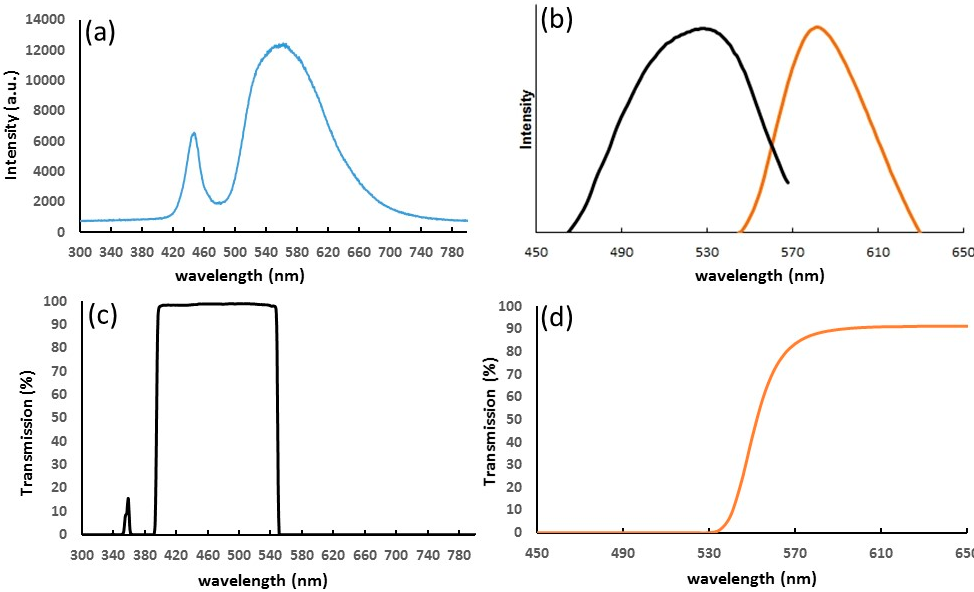
Figure 5. ( a ) iPod LED emission spectra; ( b ) absorption (black) and emission (orange) spectra of orange phosphorex microspheres (from [24]); transmission spectra of filters: ( c ) short pass Thorlabs FESH0550 and ( d ) long pass Thorlabs FGL 550 (from [25]).